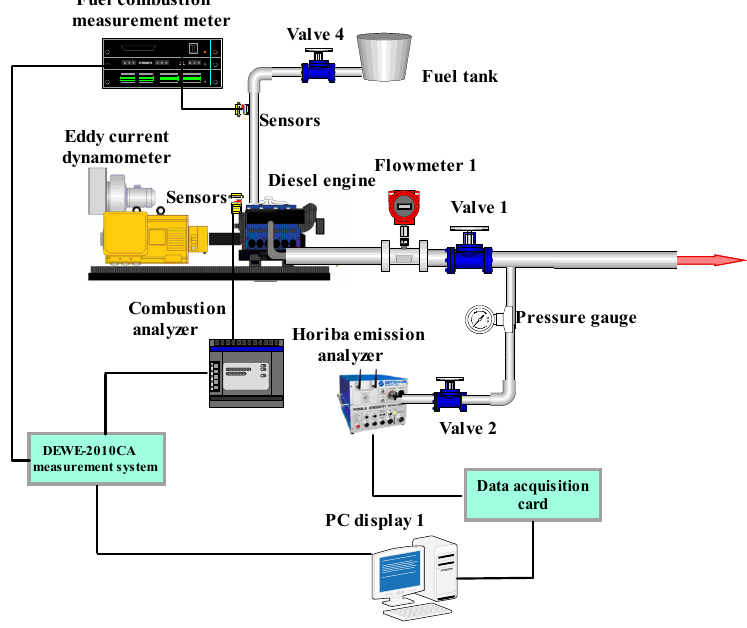
Figure 2. Schematics of experimental